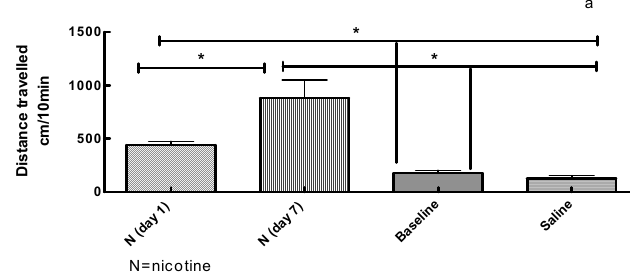
Figure 2. Effects of NT69L on locomotor activity in rats exposed to nicotine and cocaine. Male Wistar rats (n = 4-16 per group) were injected twice daily for seven days with nicotine (0.35 mg/kg s.c.) or saline control followed by four daily injections of cocaine (20 mg/kg i.p.). Cocaine challenge (20 mg/kg i.p.) was administered 48 h after the last cocaine injection. NT69L (1 mg/kg i.p.) was administered 30 min prior to cocaine injection on